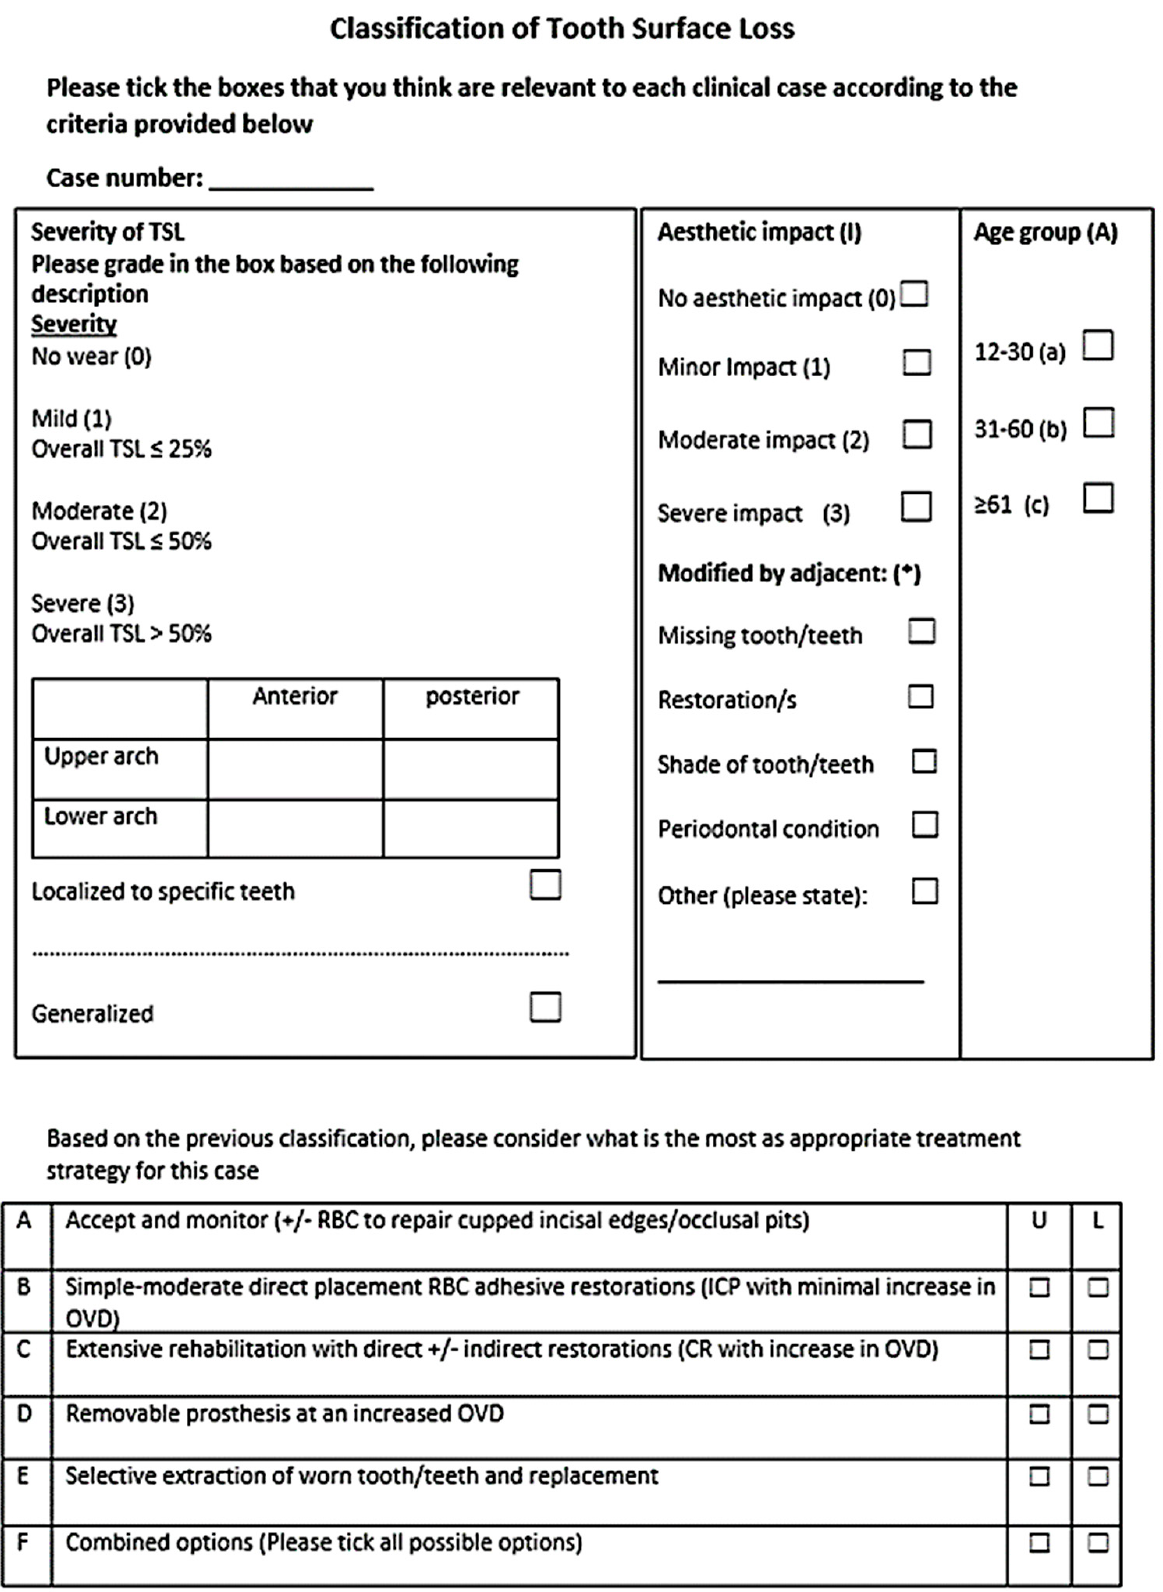
Figure 1. First classification tool in the pilot study.